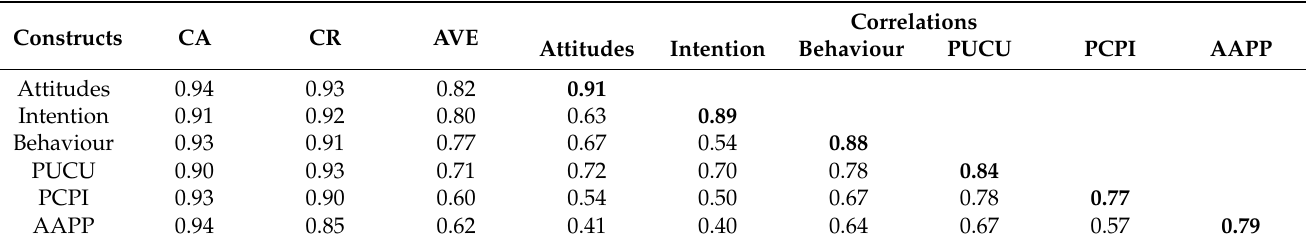
Table 4. Correlations, Cronbach’s alpha (CA), composite reliability (CR), and average variance extracted (AVE).